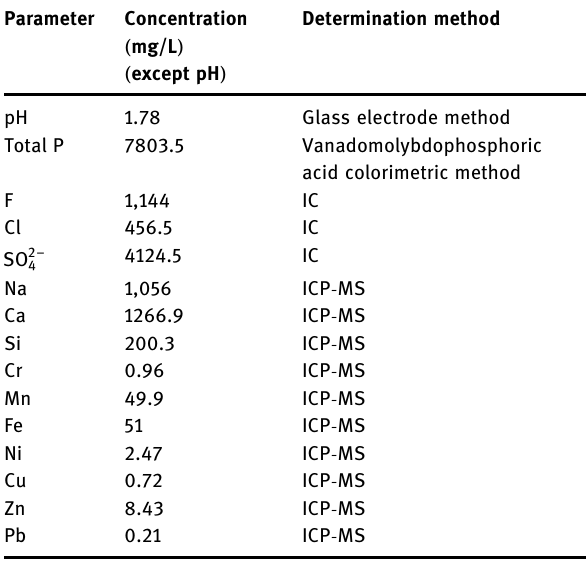
Table 1: Chemical composition of fl y ash and synthetic zeolite ( wt% ) Element Si